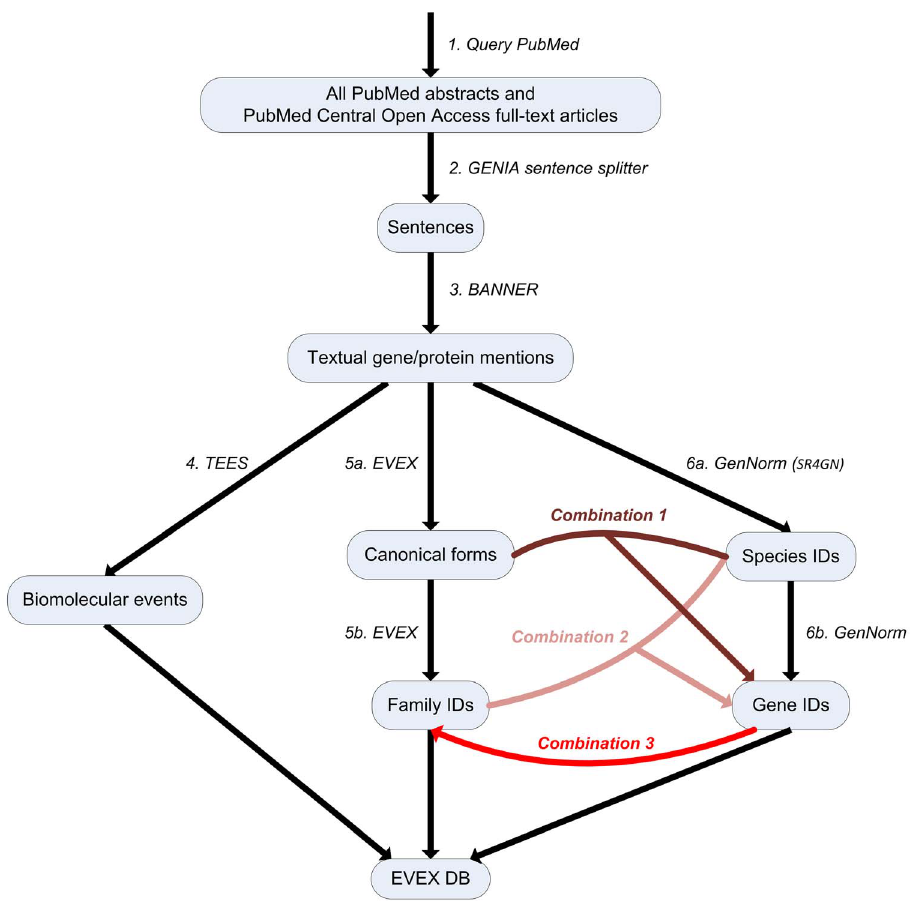
Figure 2. Overview of the various steps and programs involved in this study. The black arrows represent previously published tools, which have all been integrated in this study to create a unified text mining pipeline. Furthermore, the various opportunities for combining the different methods for gene normalization are presented by the colored edges and discussed in detail in the text.